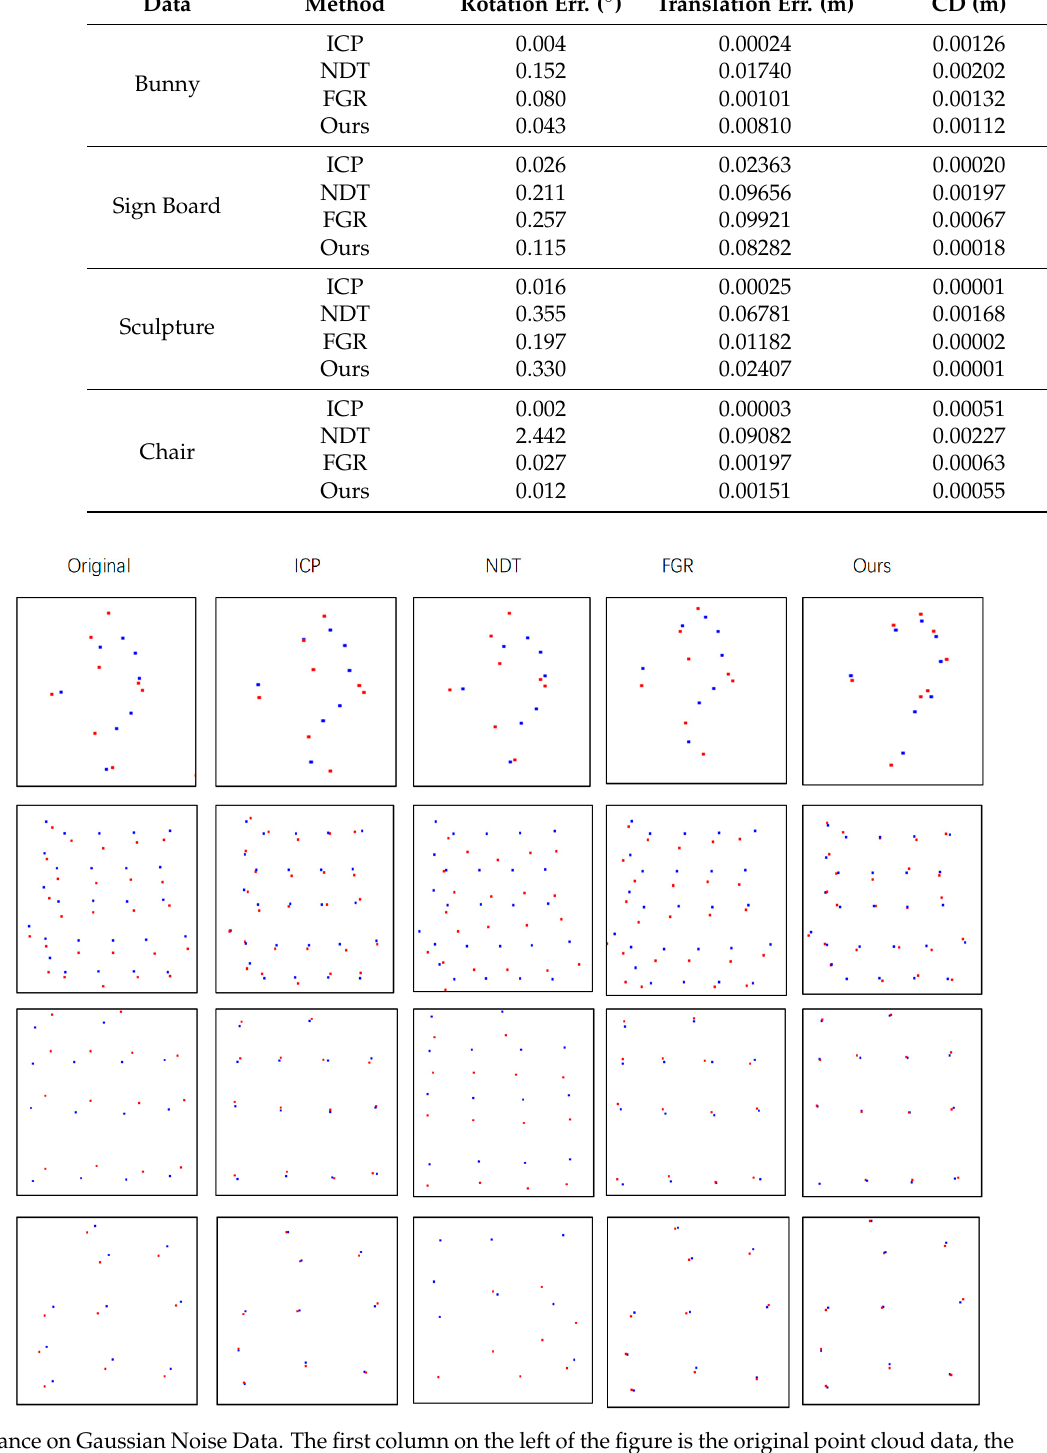
Figure 10. Performance on Gaussian Noise Data. The first column on the left of the figure is the original point cloud data, the second column is the detailed schematic diagram and the rest are the detailed diagrams after registration by each method. Table 4. Performance on Distorted Data.